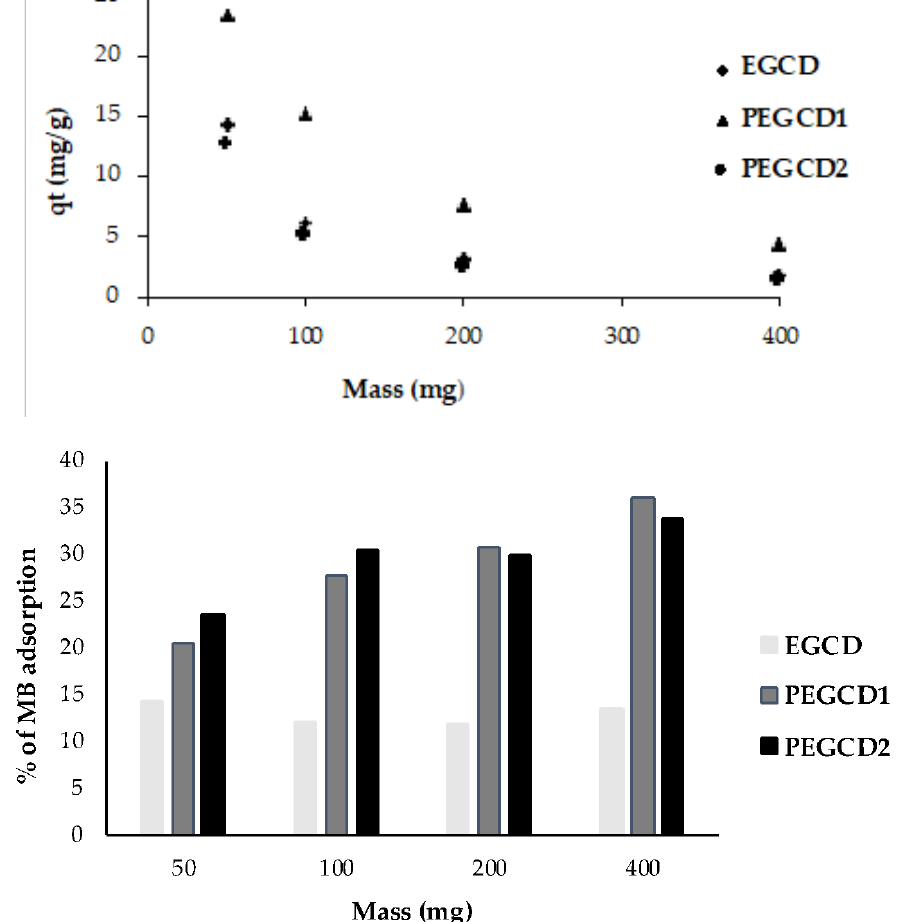
Figure 7. ( Top ) E ff ect of the adsorbent mass on the adsorption capacities of MB; and ( Bottom ) e ff ect of Figure 7. ( Top ) Effect of the adsorbent mass on the adsorption capacities of MB; and ( Bottom ) effect the adsorbent mass on the percentage of MB of the adsorbent mass on the percentage of MB adsorption.